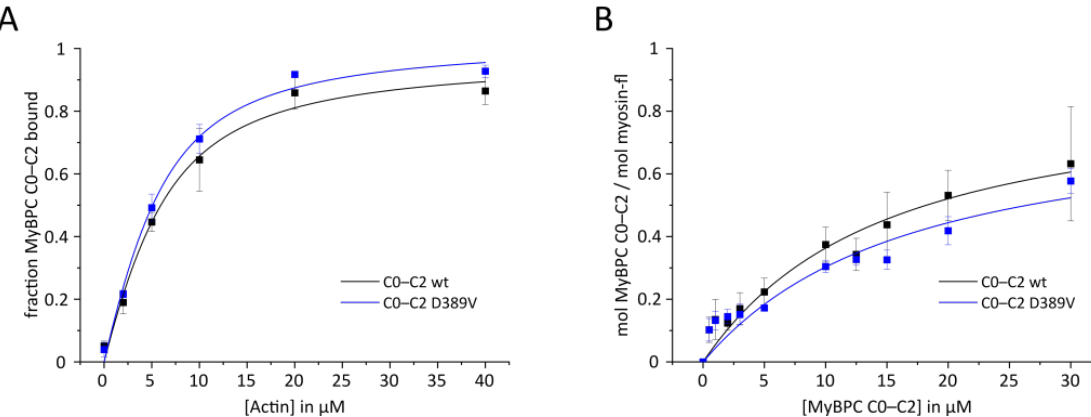
Figure 5. High-speed cosedimentation experiments of MyBPC C0–C2 with F-actin and β-cardiac myosin. ( A ) Actin (0–40 µM) and MyBPC C0–C2 (5 µM) were cosedimented and the fraction of C0–C2 in the pellet was determined. A quadratic fit yields the dissociation constants K d for wt of 3.2 ± 0.9 µM and D389V of 2.8 ± 0.6 µM. ( B ) MyBPC C0–C2 (0–30 µM) was cosedimented with 2.5 µM of β-cardiac myosin. The amount of C0–C2 bound to synthetic thick filaments was determined using a protein standard range of C0–C2. A quadratic fit yields K d values for wt of 12.7 ± 4.7 µM and D389V of 14.8 ± 7.7 µM. Data points indicate mean ± SD from at least n = 3 experiments.